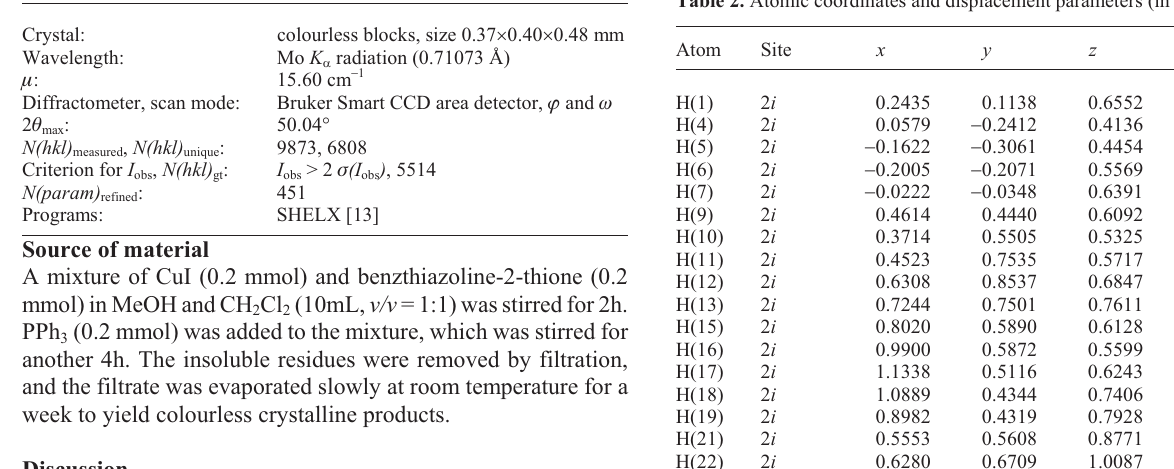
Table 1. Data collection and handling.